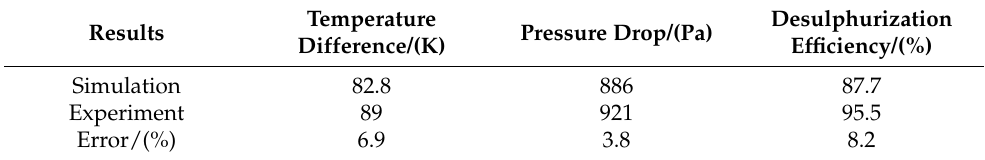
Table 4. Experimental